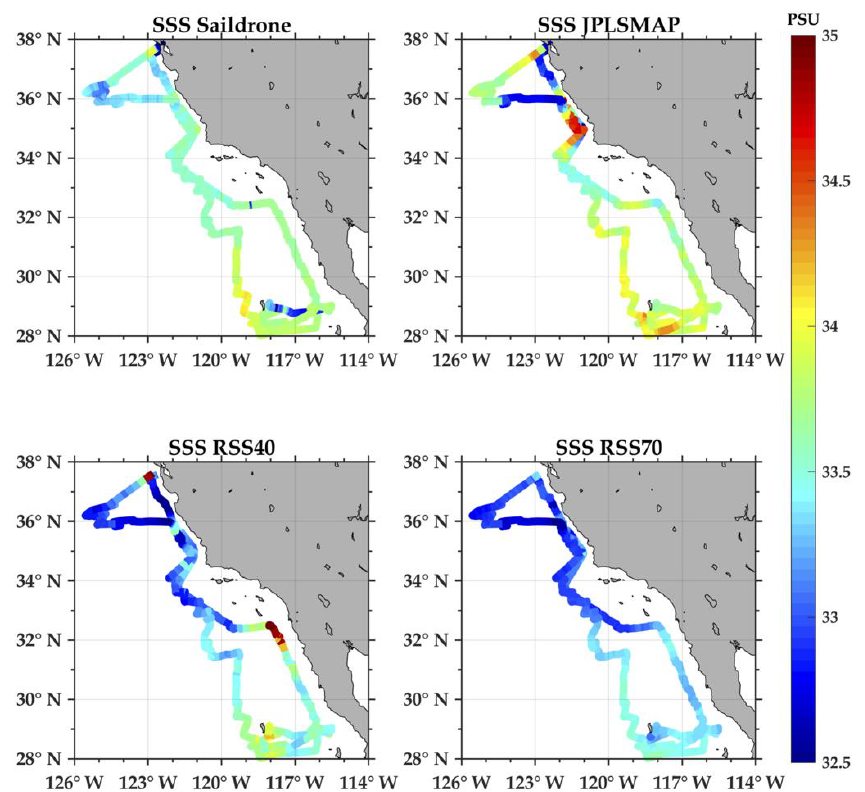
Figure 2. Sea surface salinity (SSS) from a Saildrone CTD, JPLSMAP, RSS40, and RSS70.